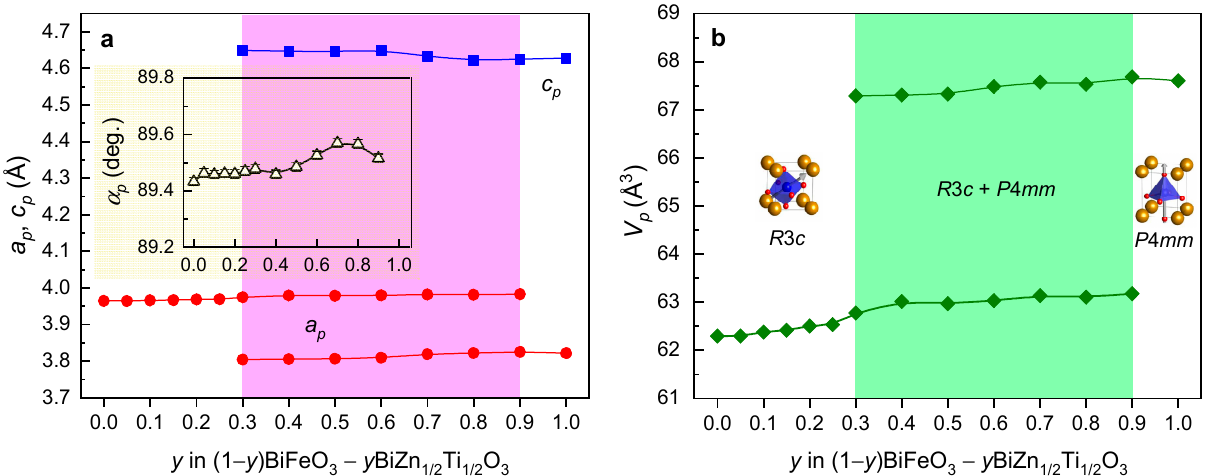
Figure 2. ( a ) The primitive perovskite cell parameters and ( b ) the normalized unit-cell volume of the BiFe 1 − y [Zn 0.5 Ti 0.5 ] y O 3 perovskite phases as a function of y with the ranges of phase coexistence (0.30 ≤ y ≤ 0.90) indicated. The data for the end members ( y = 0 and y = 1) were taken from Refs. [31,35], respectively. The polyhedral representations of the respective structures are shown.